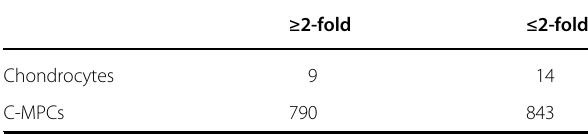
Table 2 Expression-level comparisons of selected osteoblastic genes between the β -catenin – C-MPCs and control